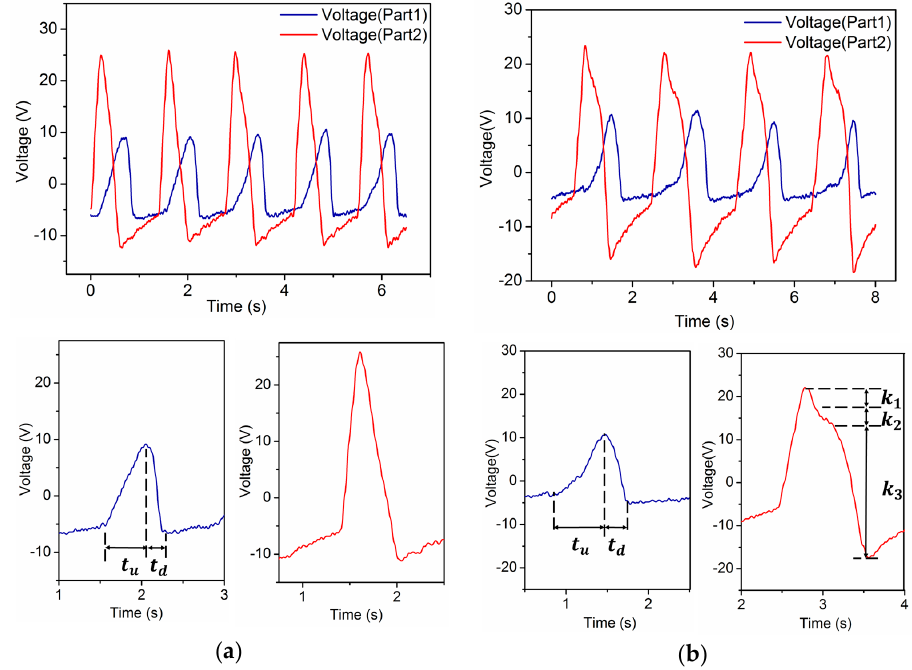
Figure 4. Waveforms and characteristics of voltage output from self-powered insole. ( a ) Waveforms and characteristics of normal walking, t u > t d in voltage of part1; ( b ) Waveforms and characteristics of strolling, t u > t d in voltage of part1, | k 2 | < | k 1 | ≈ | k 3 | in voltage of part2.